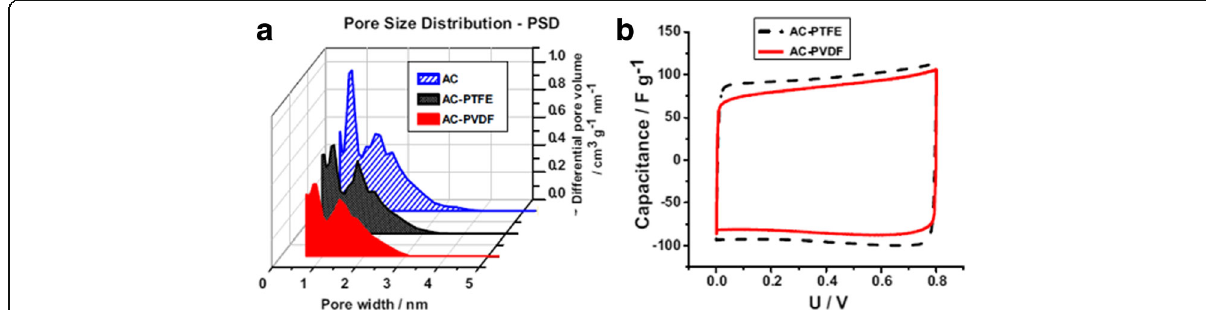
Fig. 2 a Pore size distribution of AC, AC-PTFE, and AC-PVDF electrodes. b Cyclic voltammograms (2 mV · s − 1 ) up to 0.8 V of AC/AC capacitors in 1 mol · L -1 NaNO3 with PTFE and PVDF binders. Reprinted with permission from [19]. Copyright 2014